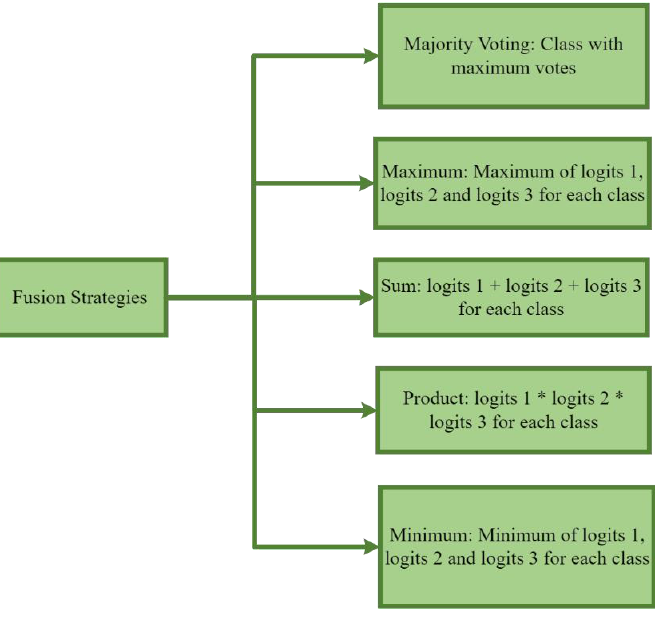
Figure 2. Different Fusion Strategies.